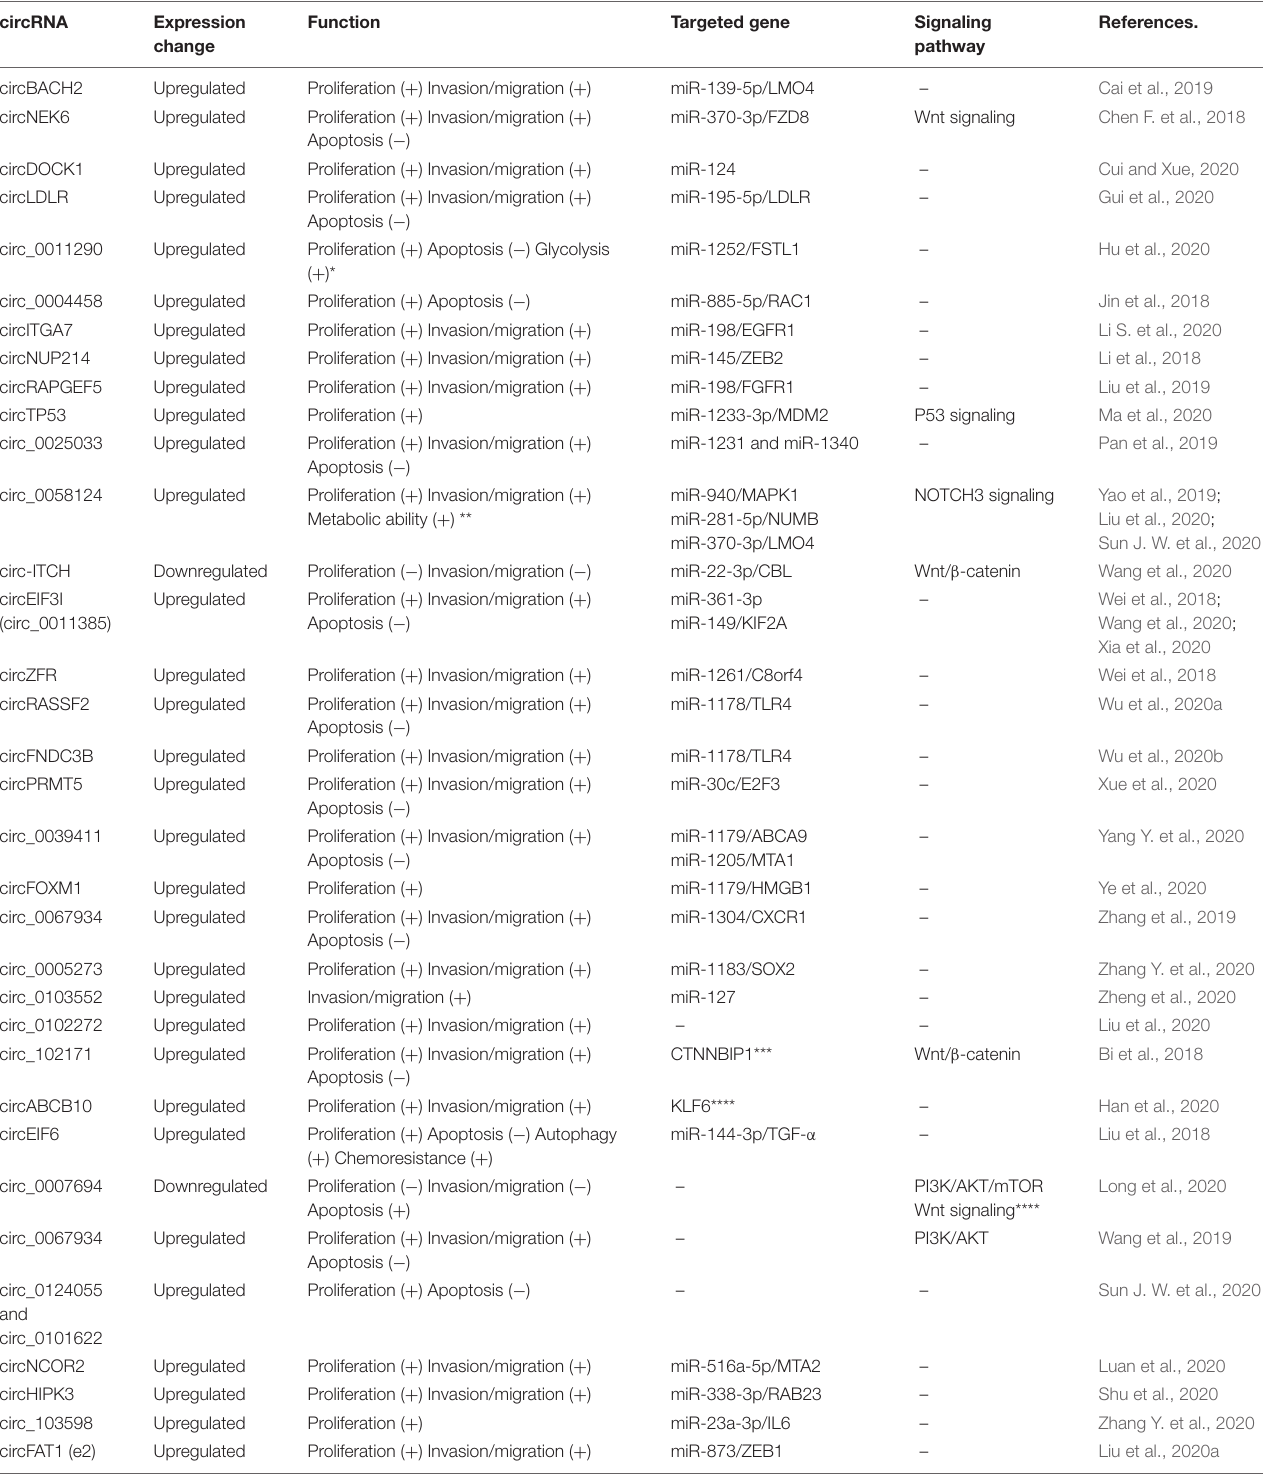
TABLE 2 | Dysregulated circRNAs in thyroid